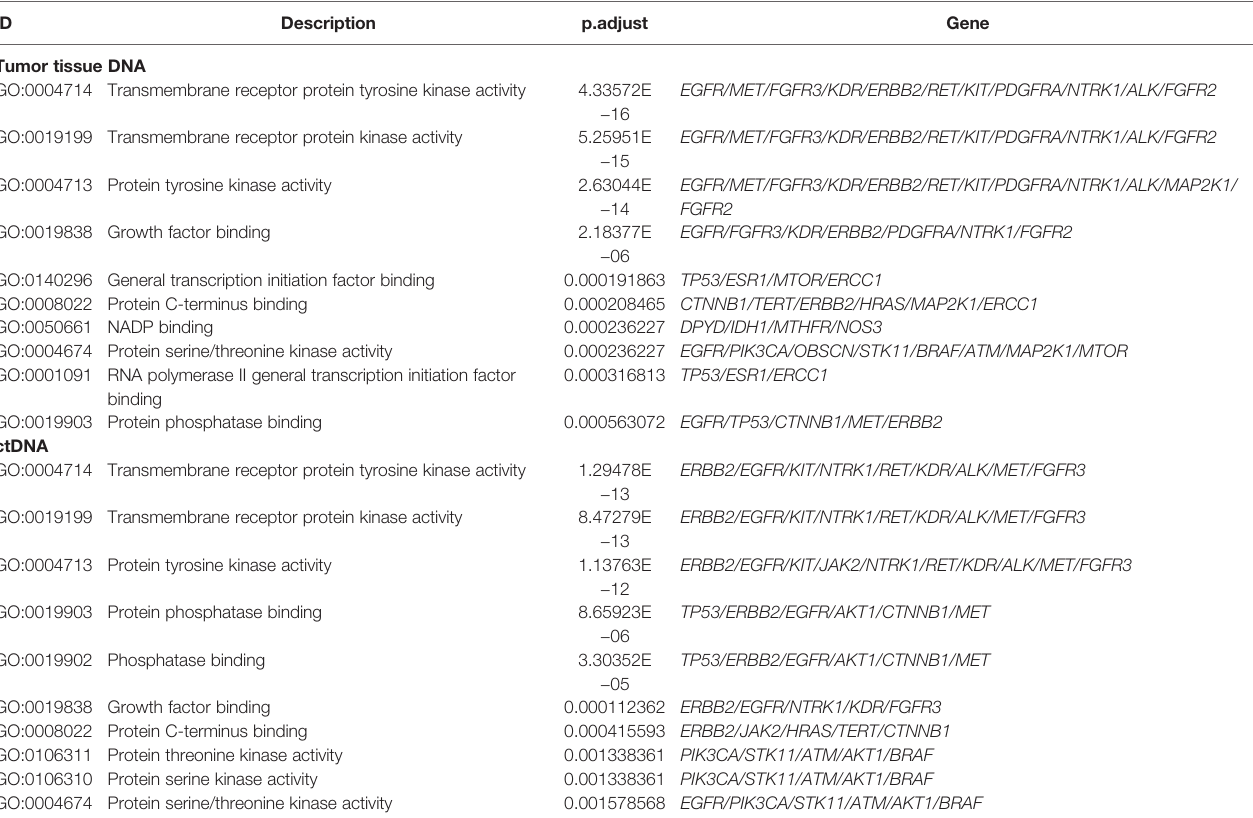
TABLE 3 | Functional terms enriched by GO analysis of somatic mutations in 199 tumor tissue samples and 125 plasma